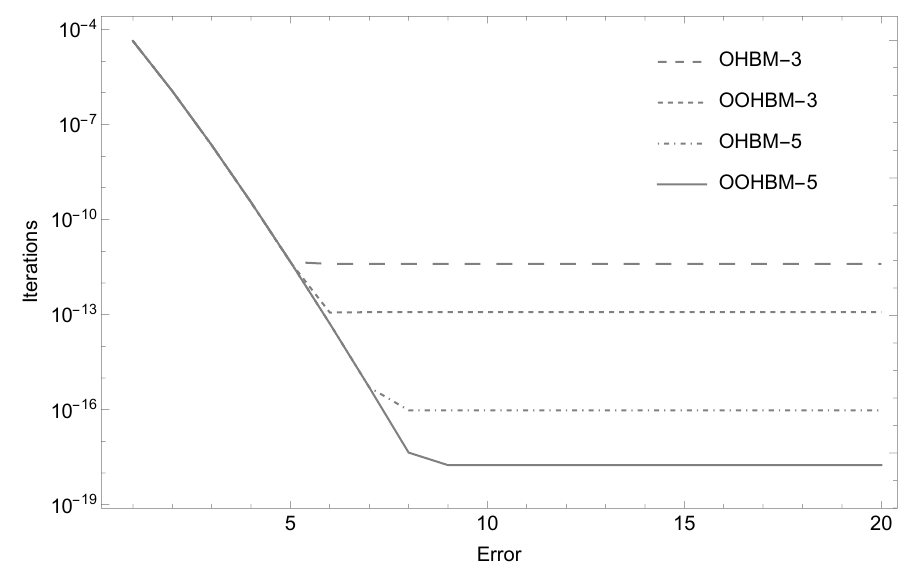
Figure 3. Comparison of the convergence plots for Example 1 when h = 0.01.